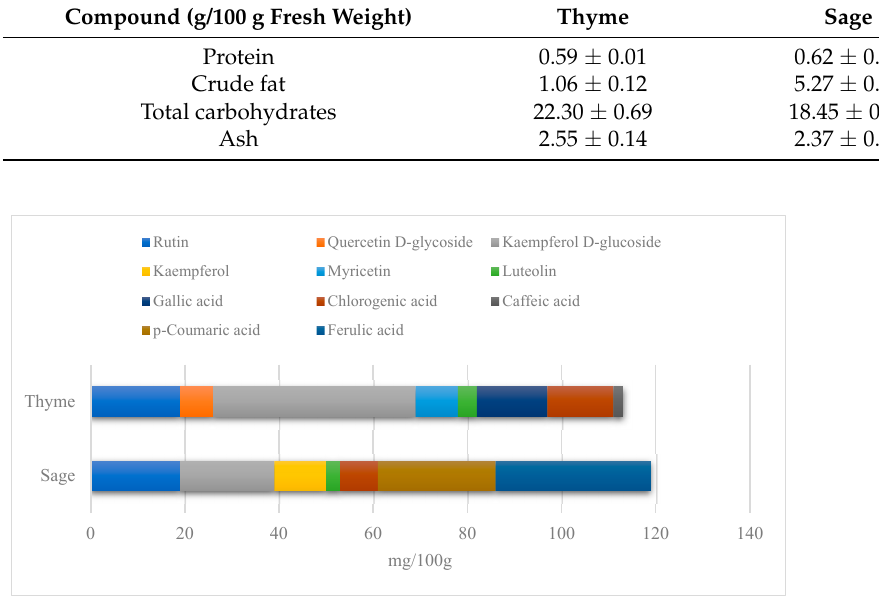
Figure 1. Fillers after drying and milling: thyme ( a ) and sage ( b ). Table 2. Chemical composition of herbs. Data from [37].